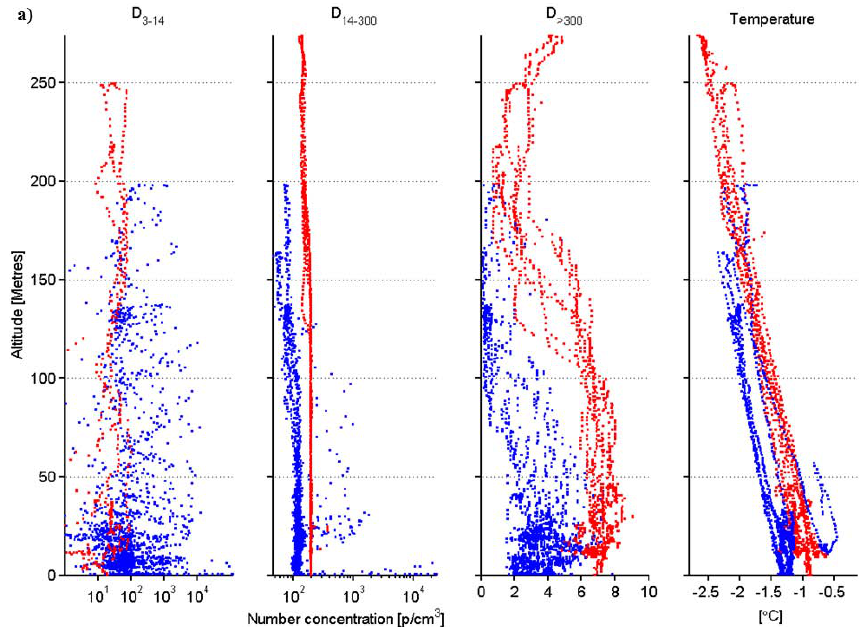
Fig. 9a. Vertical profiles of aerosol particle number concentration and temperature during ASCOS 2008 expedition helicopter flights, Period 1: 13:04–13:32UTC, 15 August (DoY 228) 2008 (red); 07:10–08:00UTC, 16 August (DoY 229) 2008 (blue).